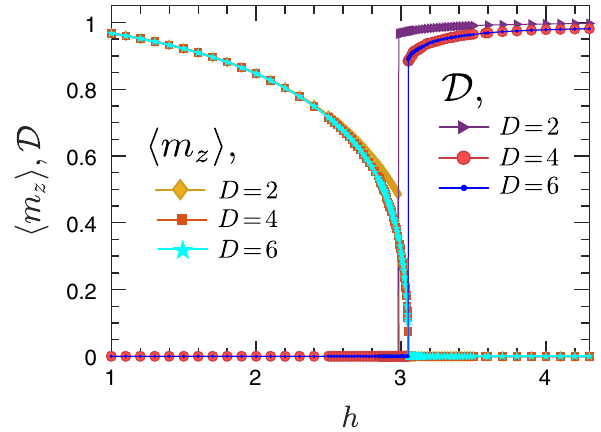
FIG. 12. Order parameter h m ( z magnetization) and disorder z i parameter D (response of normalization to inserting a semi- infinite “ symmetry twist ” ) for the ð 2 þ 1 Þ D transverse field Ising model; see the text for details.